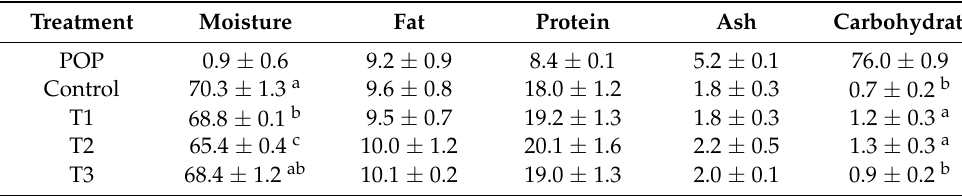
Table 2. Chemical proximate composition of POP and pork